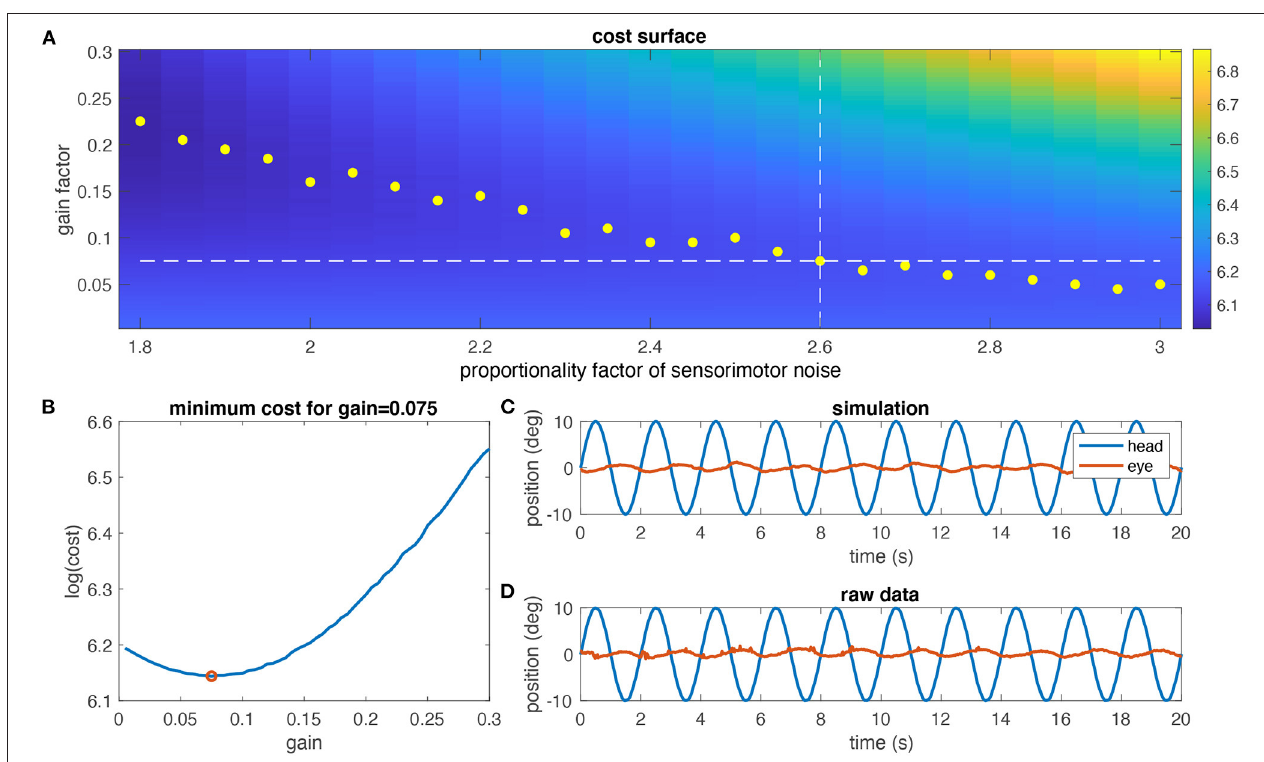
FIGURE 4 | Determination of the noise level. (A) Simulated cost surface [as log (cost)] for one animal (same as in Figures 3C,D ) and for eye movements at a stimulus frequency of 0.5Hz and ± 10 ◦ head motion amplitude plotted as function of the noise factor of sensorimotor noise and model gain factor; the cost of the aVOR has been quantified by calculating the variance of the retinal image slip; yellow dots indicate the minimum cost for each noise factor; the dashed horizontal line is the experimentally determined gain value, and the vertical dashed line the noise factor at which the optimal gain value is closest to the experimental gain value (2.6 in this case). (B) Section through the cost surface for a noise factor of 2.6; the optimal gain is 0.075, as shown in (A) . (C) Simulated eye movements (red) for the optimal gain value determined in (A,B) . (D) Raw eye movement recordings (red) for this animal for